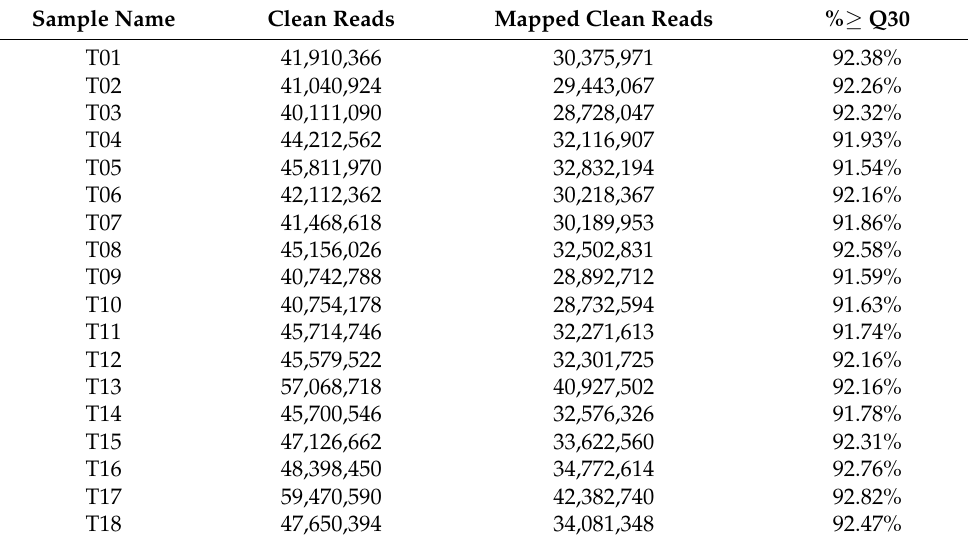
Table 2. Basic information of RNA-seq of CK, T12, and F20 before and after salt stress.